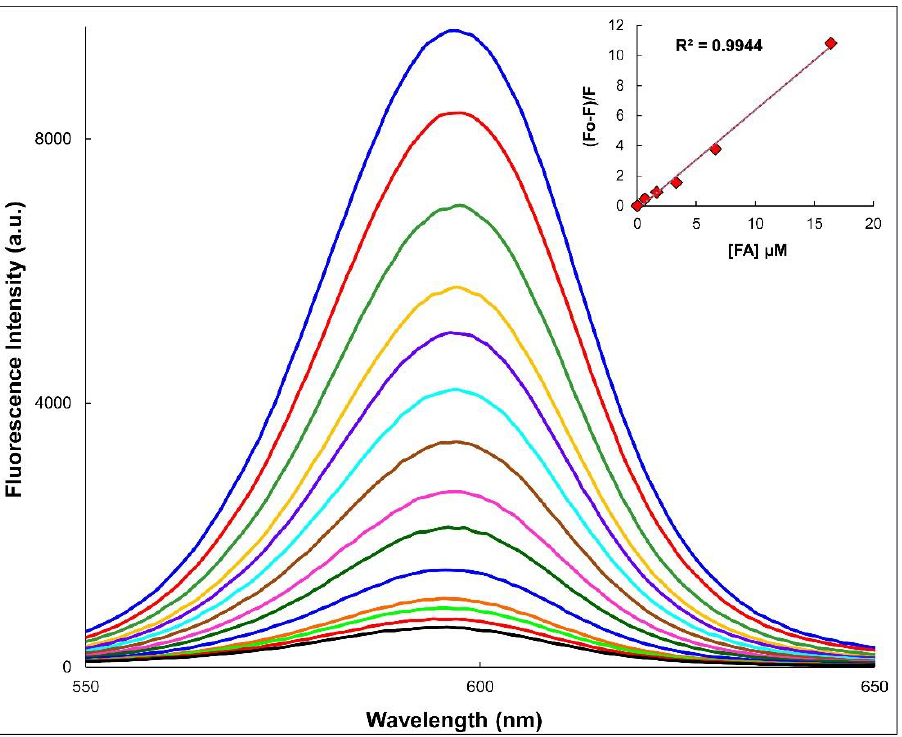
Figure 5. Fluorescence spectra of CdTe / CA QDs in PBS bu ff er solution (pH 8). Concentration range of FA = 0.16–16.4 µ M. The inset shows the FA calibration curve (average from three